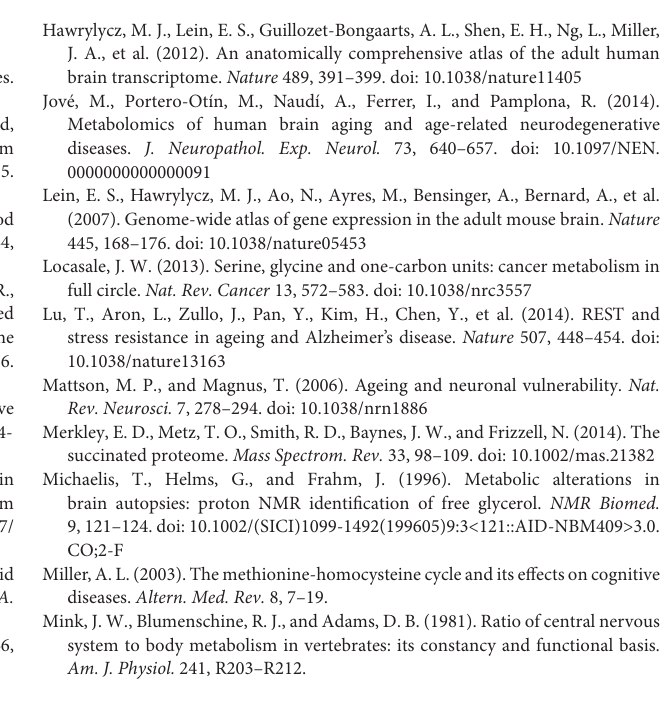
FIGURE S1 | Western blots of tissue protein expression of factors associated with stress resistance and cell survival in different regions of the adult human cerebral